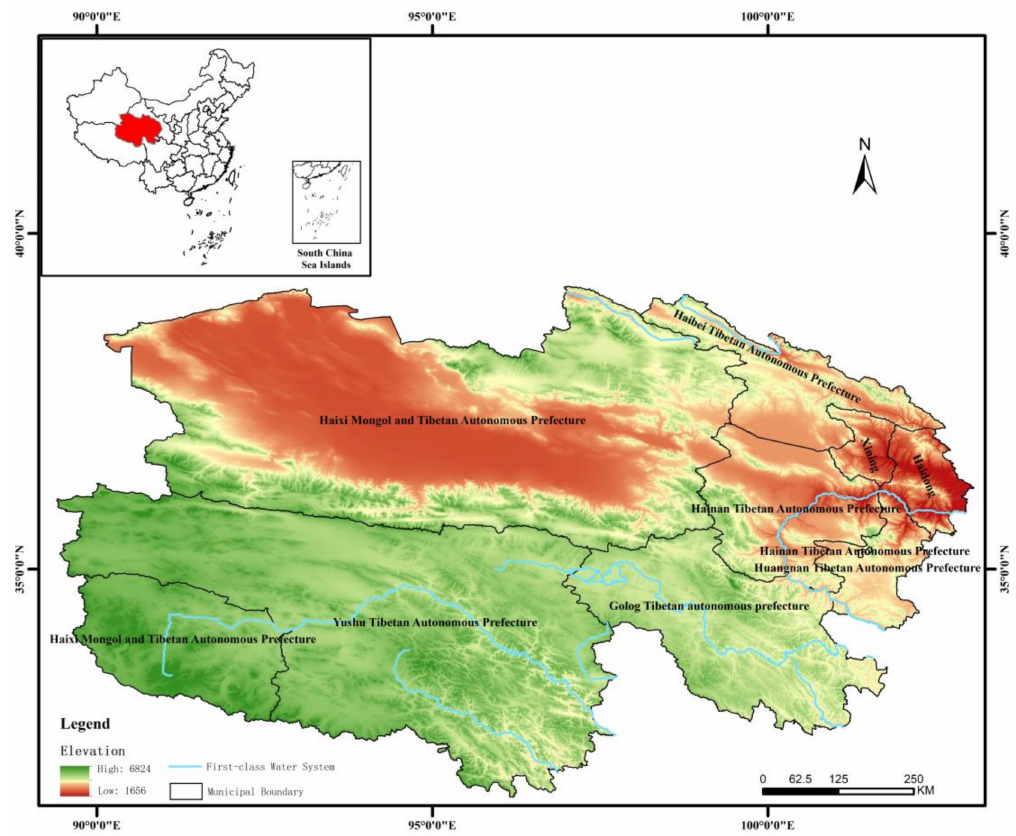
Figure 1. Location of Qinghai Province,